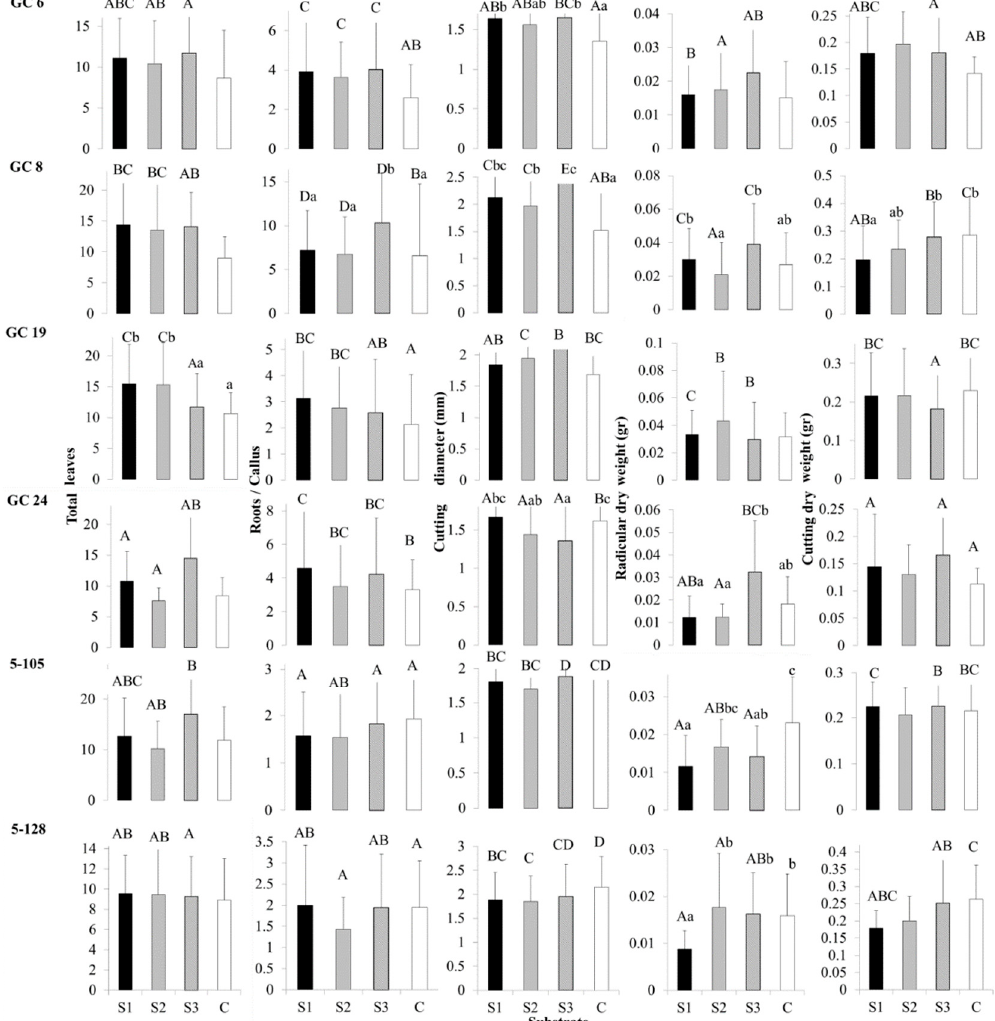
Figure 2. Growth variables (Total Leaves, Roots/callus, Cutting Diameter, Radicular Dry Weight, Cutting Dry Weight) in four substrates (1, 2, 3, and control) and six clones (GC6, GC8, GC19, GC24, 5–105 and 5–128). The bars indicate mean values of Total Leaves, Roots/callus, Cutting Diameter, Radicular Dry Weight, and Cutting Dry Weight of eight replicates ± standard deviation. Different lowercase letters indicate significant differences between substrates for each variable analyzed ( p ≤ 0.05). Different capital letters indicate significant differences between genotypes for each variable analyzed ( p ≤ 0.05). For no significant difference, no letters are shown.